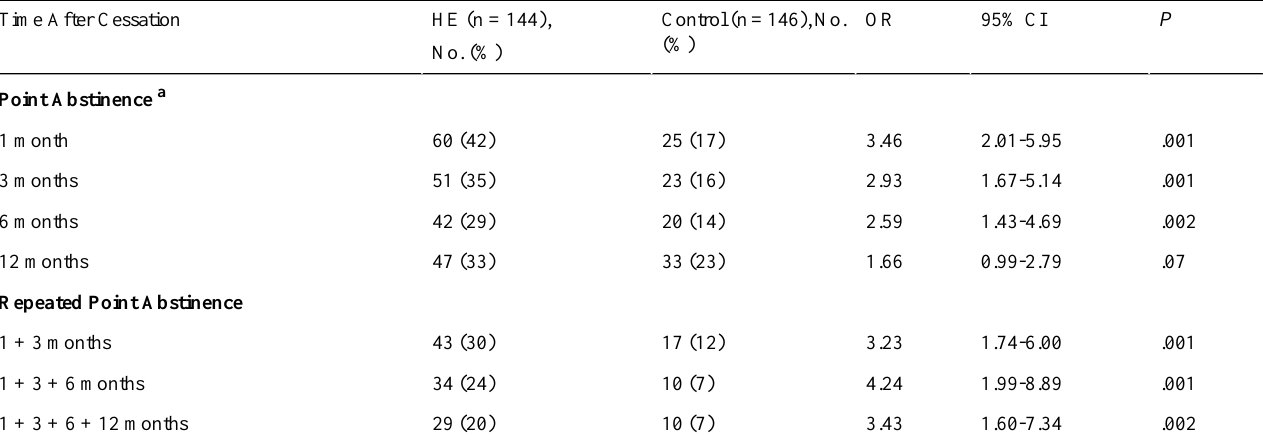
Table 5. Point abstinence and repeated point abstinence rates across conditions at specified time